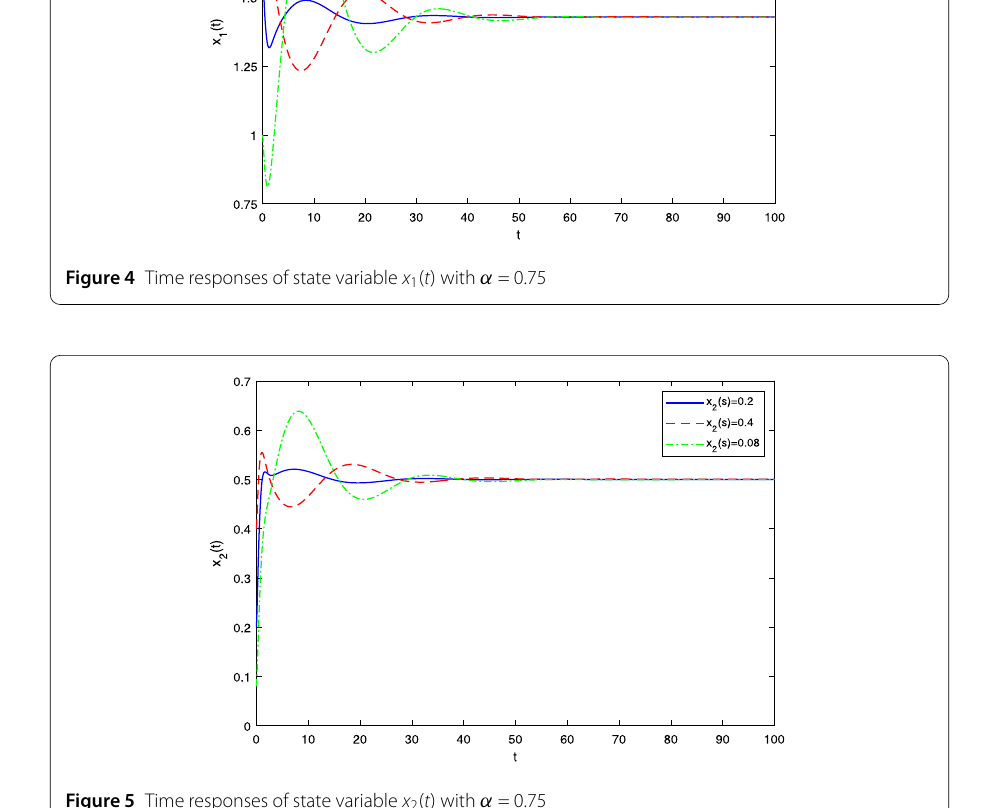
Figure 5 Time responses of state variable x 2 ( t ) with α = 0.75